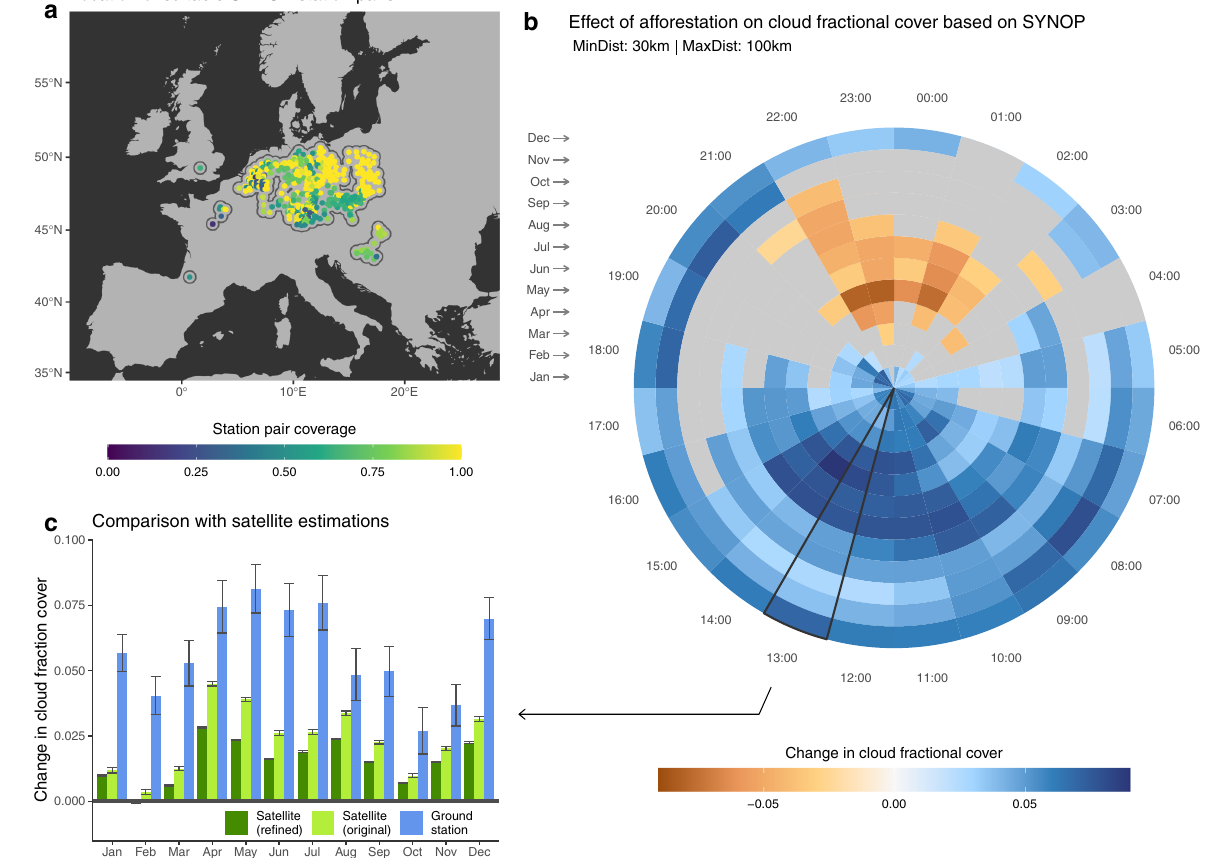
Fig. 4 Changes in cloud fractional cover (CFrC) following afforestation as estimated from paired ground stations. a Location of the usable pairs of SYNOP ground stations after selecting those where the distance among the pairs is between 30 and 100 km, and which report a suf fi ciently dense observation coverage during the period 2004 – 2014. The coverage reported in the colour bar represents the fraction of the bins in ( b ) to which the station contributes. b Average change in CFrC after potential afforestation for the region declined by month and hour. Sectors of the disk in grey represent those where the difference in not greater than two times the standard error (note that the colour bar here extends to higher values that similar bars in the rest of the fi gures). c Direct comparison with satellite observations for the time slice nearest to the satellite overpass time (circa 13:30 at the equator). The value of the satellite estimates, for both the re fi ned (0.02°) and the original (0.05°) products, is the mean of all records collected based on a buffer of 50 km around the ground stations, and which is portrayed in ( a ). The error bars represent one standard error around the